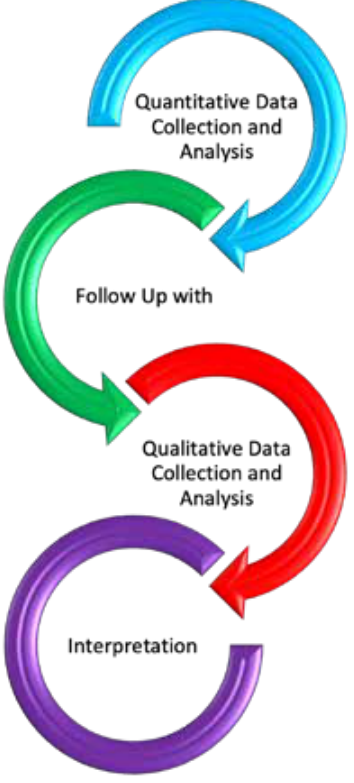
Figure 2. Mixed Method Research Design 30 m Sprint Run (s). This instrument used to measure the level of speed. This test was carried out by standing at the start line and after the whistle sounded, the participant run as fast as possible for 30 meters to the finish line. The assessment was carried out by calculated the score which was based on the fastest time. This instrument was tested beforehand in this study with a validity value of 0.80 and a reliability of